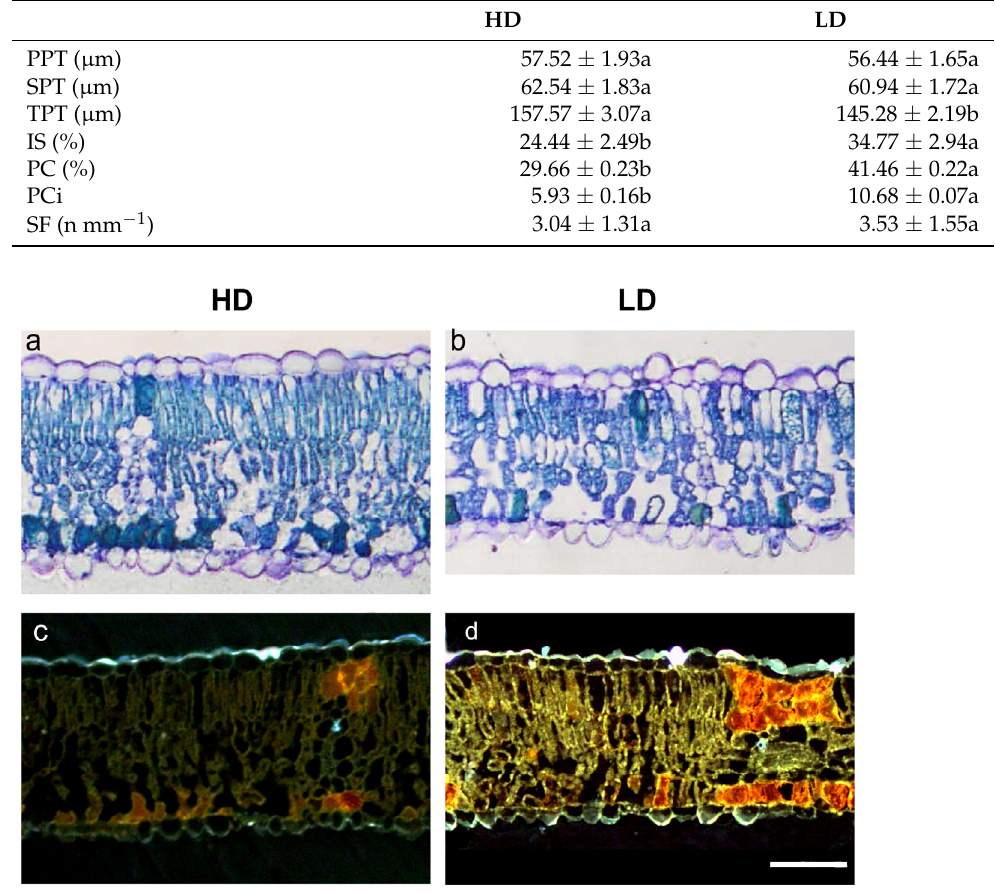
Figure 2. Light ( a , b ) and epi-fluorescence ( c , d ) microscopy views of leaf lamina cross-section of R. pseudoacacia HD ( a , c ) and LD ( b , d ) plants. Images are at the same magnification; scale bar = 50 µm.